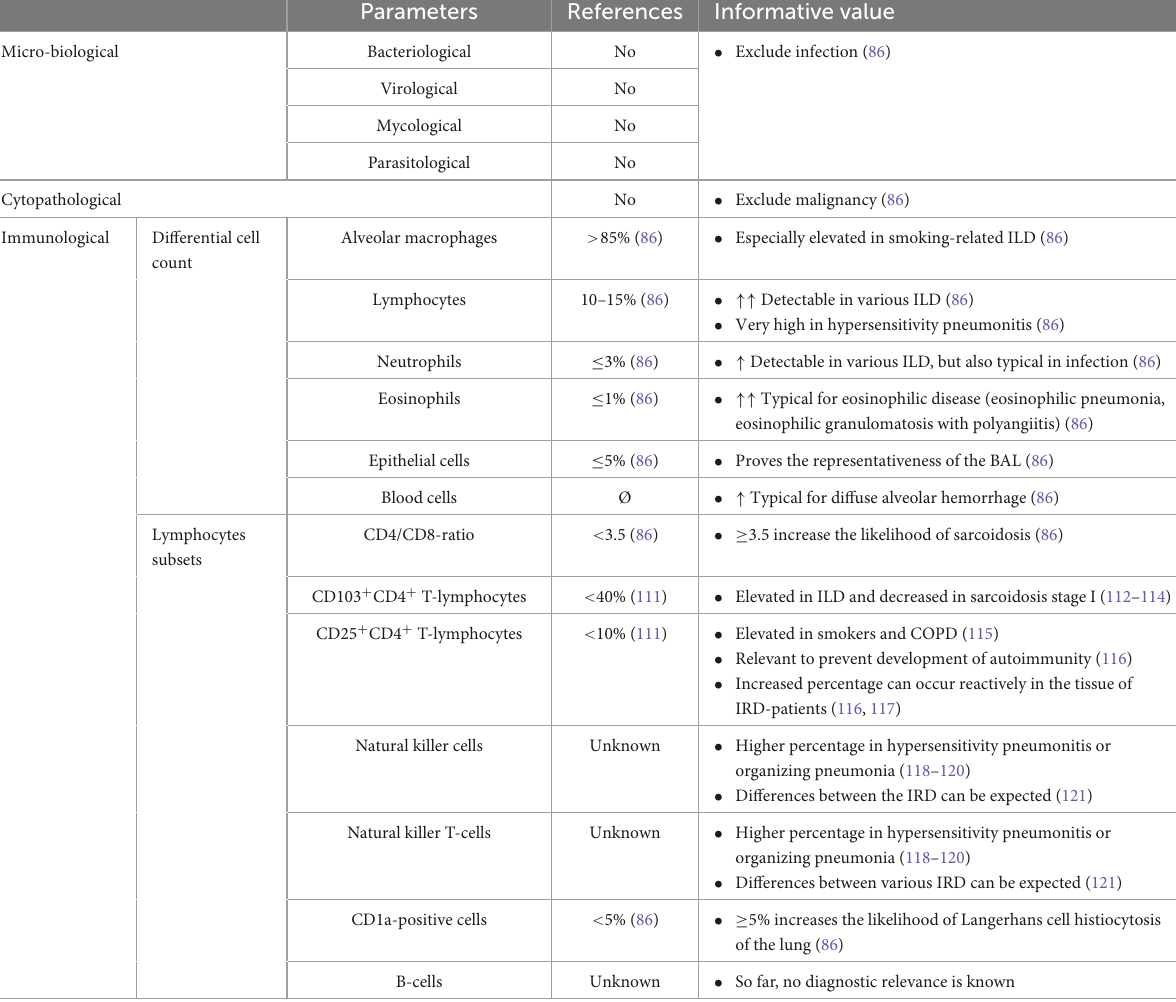
TABLE 6 Informative value of different parameters in bronchoalveolar lavage (BAL) in ILD.